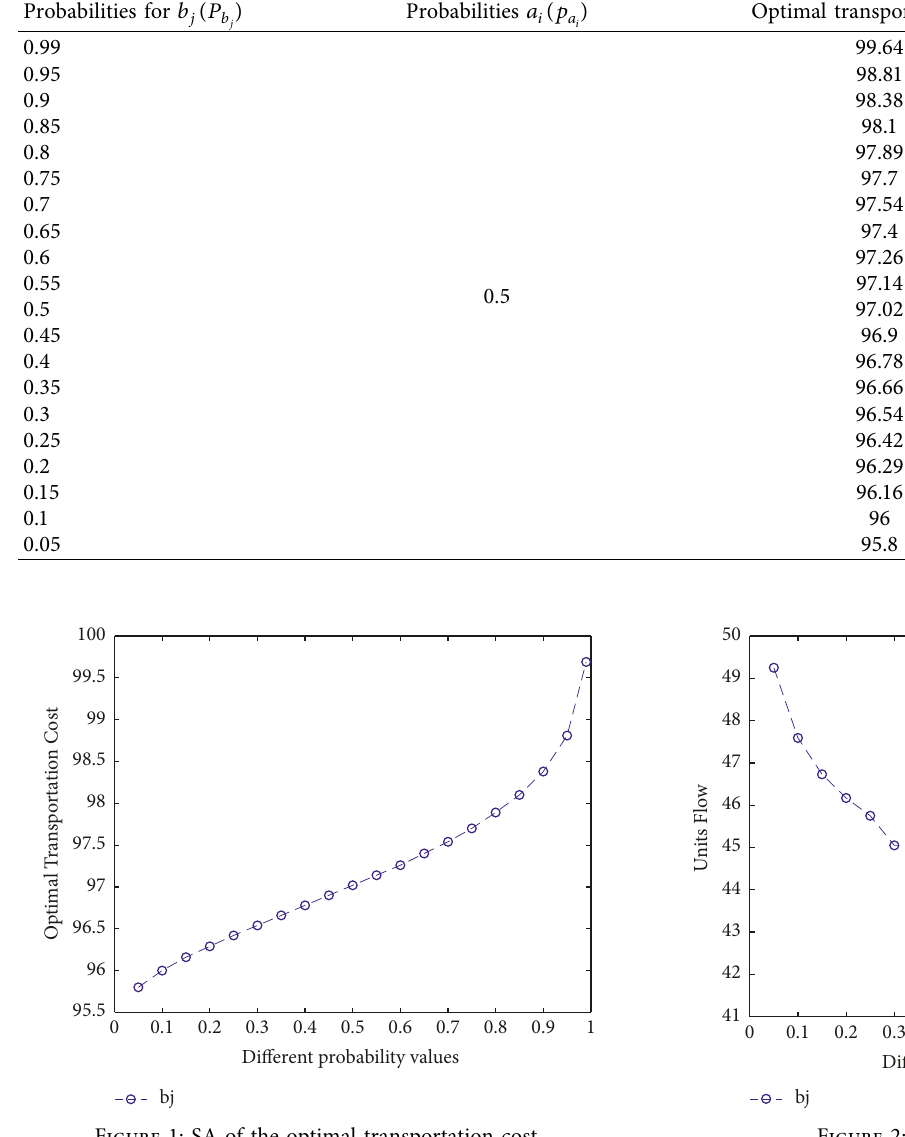
Table 5: Sensitivity analysis of SFTPMC by the varying probability of ( p